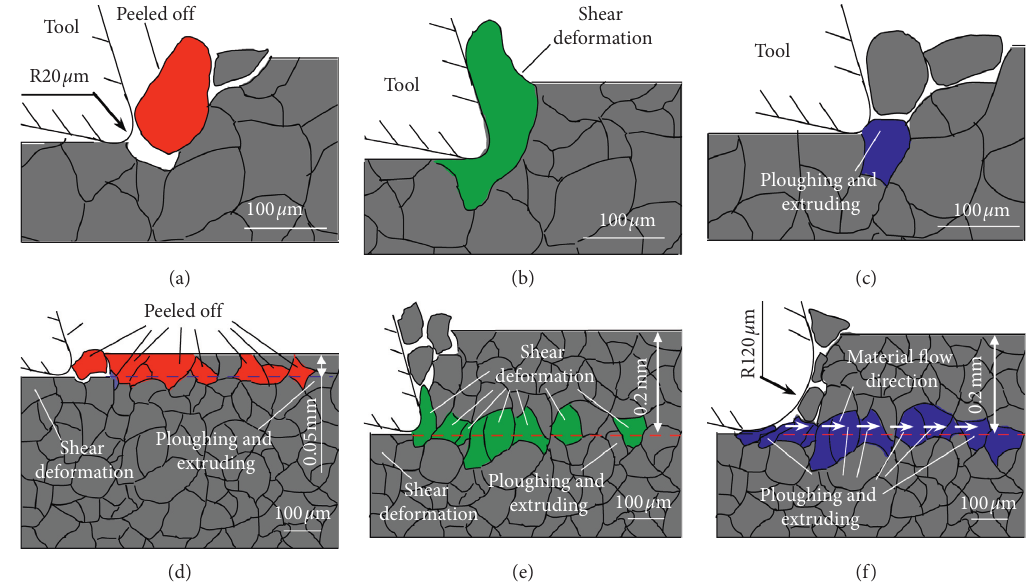
Figure 5: Material removal model of (a) peeled off, (b) shear deformation, and (c) ploughing and extruding. The formation process of the machined surface when the rounded edge radius is 20 μ m and cutting thickness is (d) 0.05mm or (e) 0.2mm, respectively. (f) The formation process of the machined surface at a rounded edge radius of 120 μ m and cutting thickness of 0.2